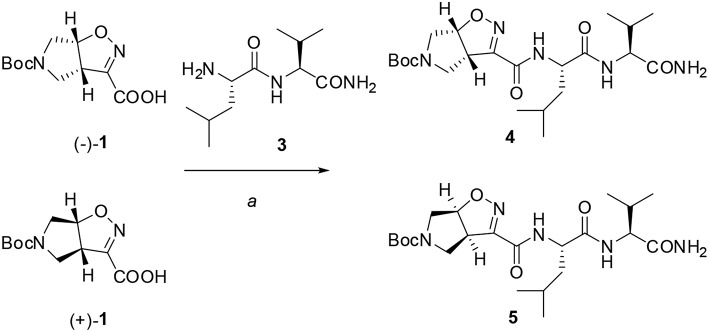
Reagents and conditions: a) EDC/HOBt/DIEA, CH2Cl2 from 0°C to r.t., 24 h.